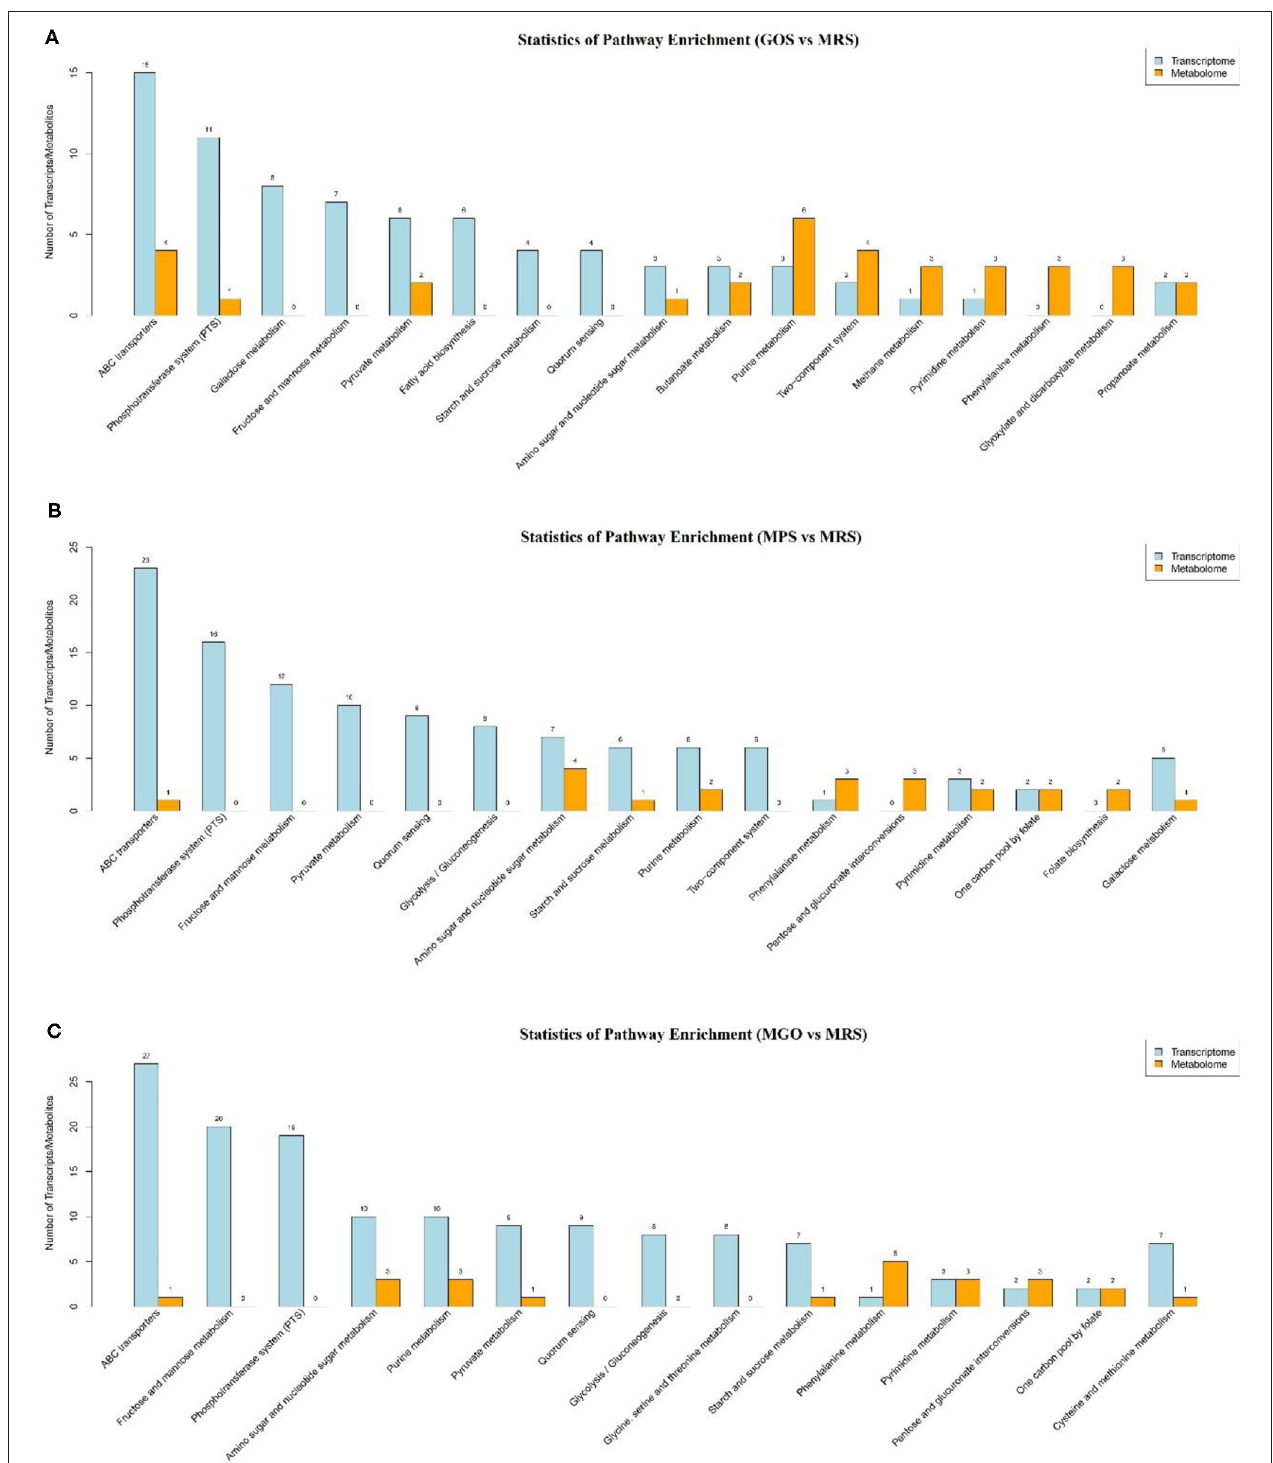
FIGURE 5 | Comparative transcriptomic and metabolomic analyses of LGG cultured with different prebiotics for 24 h. KEGG pathway enrichment analysis of DEGs. The horizontal coordinates represent the KEGG pathway name, and the vertical coordinates represent the number of transcript/metabolite unigenes. (A) GOS added to the MRS medium and culture for 24h; (B) MPS added to the MRS medium and culture for 24h; (C) MGO added to the MRS medium and culture for 24h.